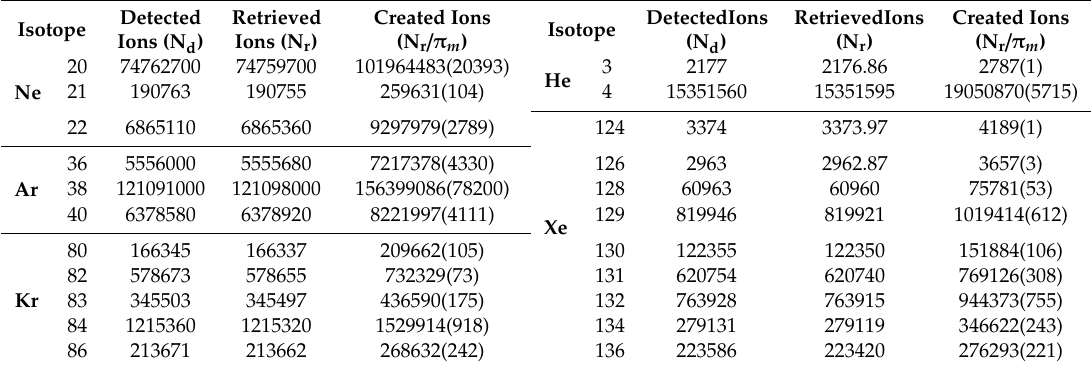
Table 9. Deconvolution e ffi ciency for noble gases in the mass spectrum in Figure 4. Parentheses contain standard uncertainties for the number of created ions inherited from detection probabilities π m found in Table